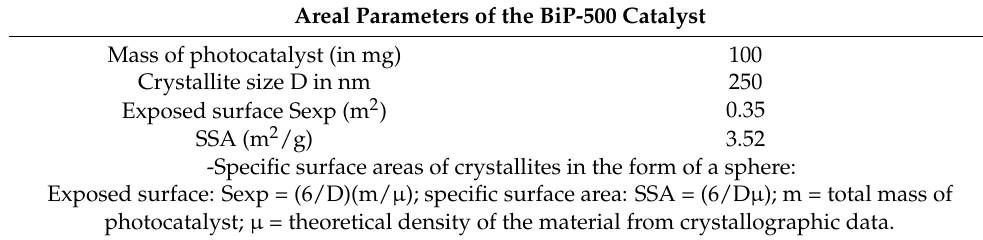
Figure 9. Distributions of particle sizes of BiP-500 photocatalyst. Table 2. Areal parameters of the BiP-500 catalyst.